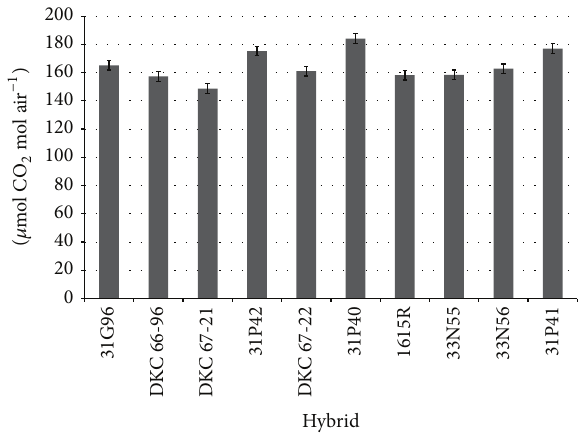
Figure 3: Mean C 𝑖 at growth stage R1 of 10 irrigated maize hybrids grown on a Bosket fine sandy loam and Tunica clay soil near Stoneville, MS. Means of 3 plants, 4 replications, 2 sites, and 2 years (2011 and 2012) ( 𝑃 ≤ 0.05 ( ± SD =